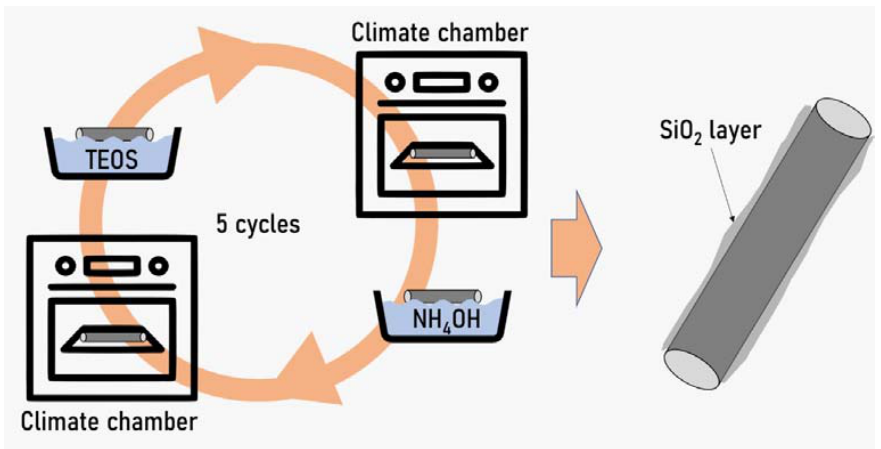
Figure 2. Scheme of formation of a nanostructured coating by sequential immersion in tetraethoxysilane and ammonia.